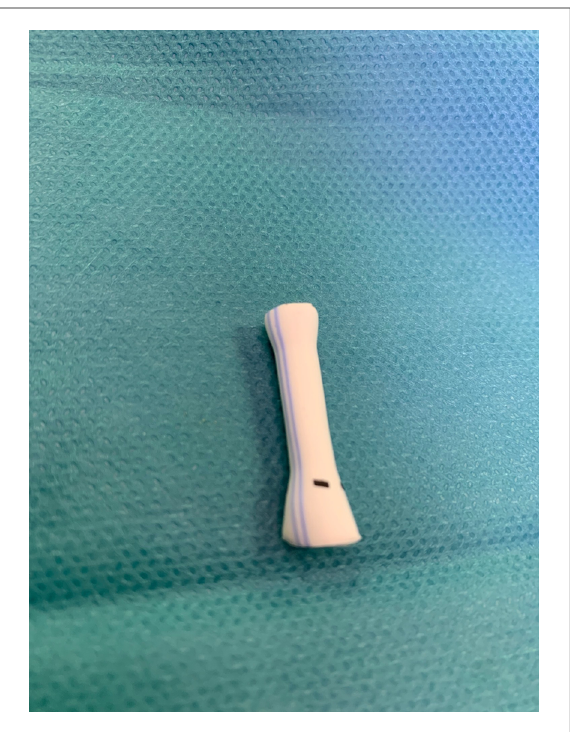
FIGURE 4 Predilatation view: distal and proximal parts of the future anastomotic